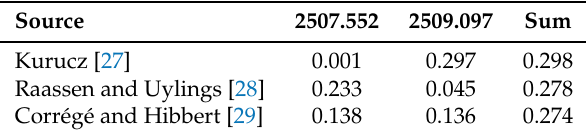
Table 4. Oscillator strengths of the 2507, 2509 Å lines in Fe II.